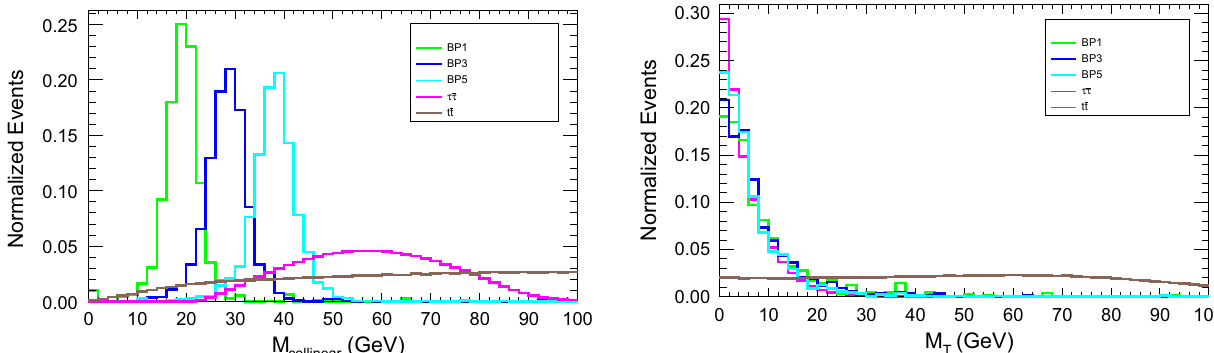
Fig. 6 Distribution of / E T (left) and invariant mass of two leptons for signal and backgrounds